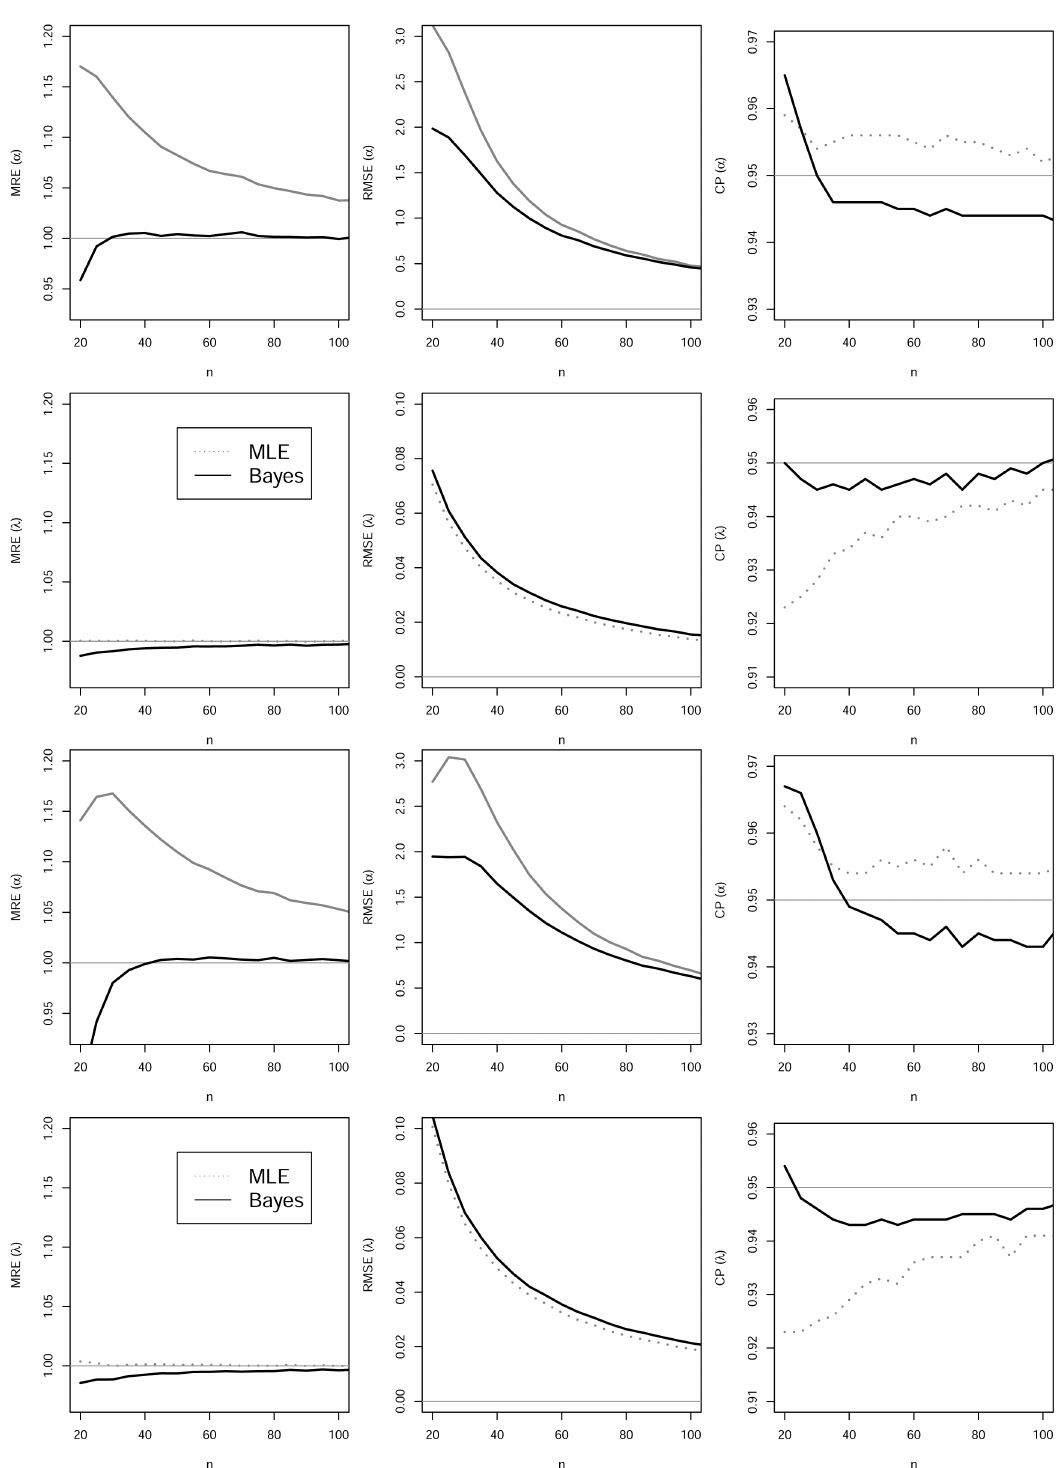
Figure 4 - MREs, RMSEs and CPs for α and λ considering α = 4, λ = 2 for N = 100,000 simulated samples, 30% (upper panel) and 50% (lower panel) of censoring and n = (20,25, ... ,100) .